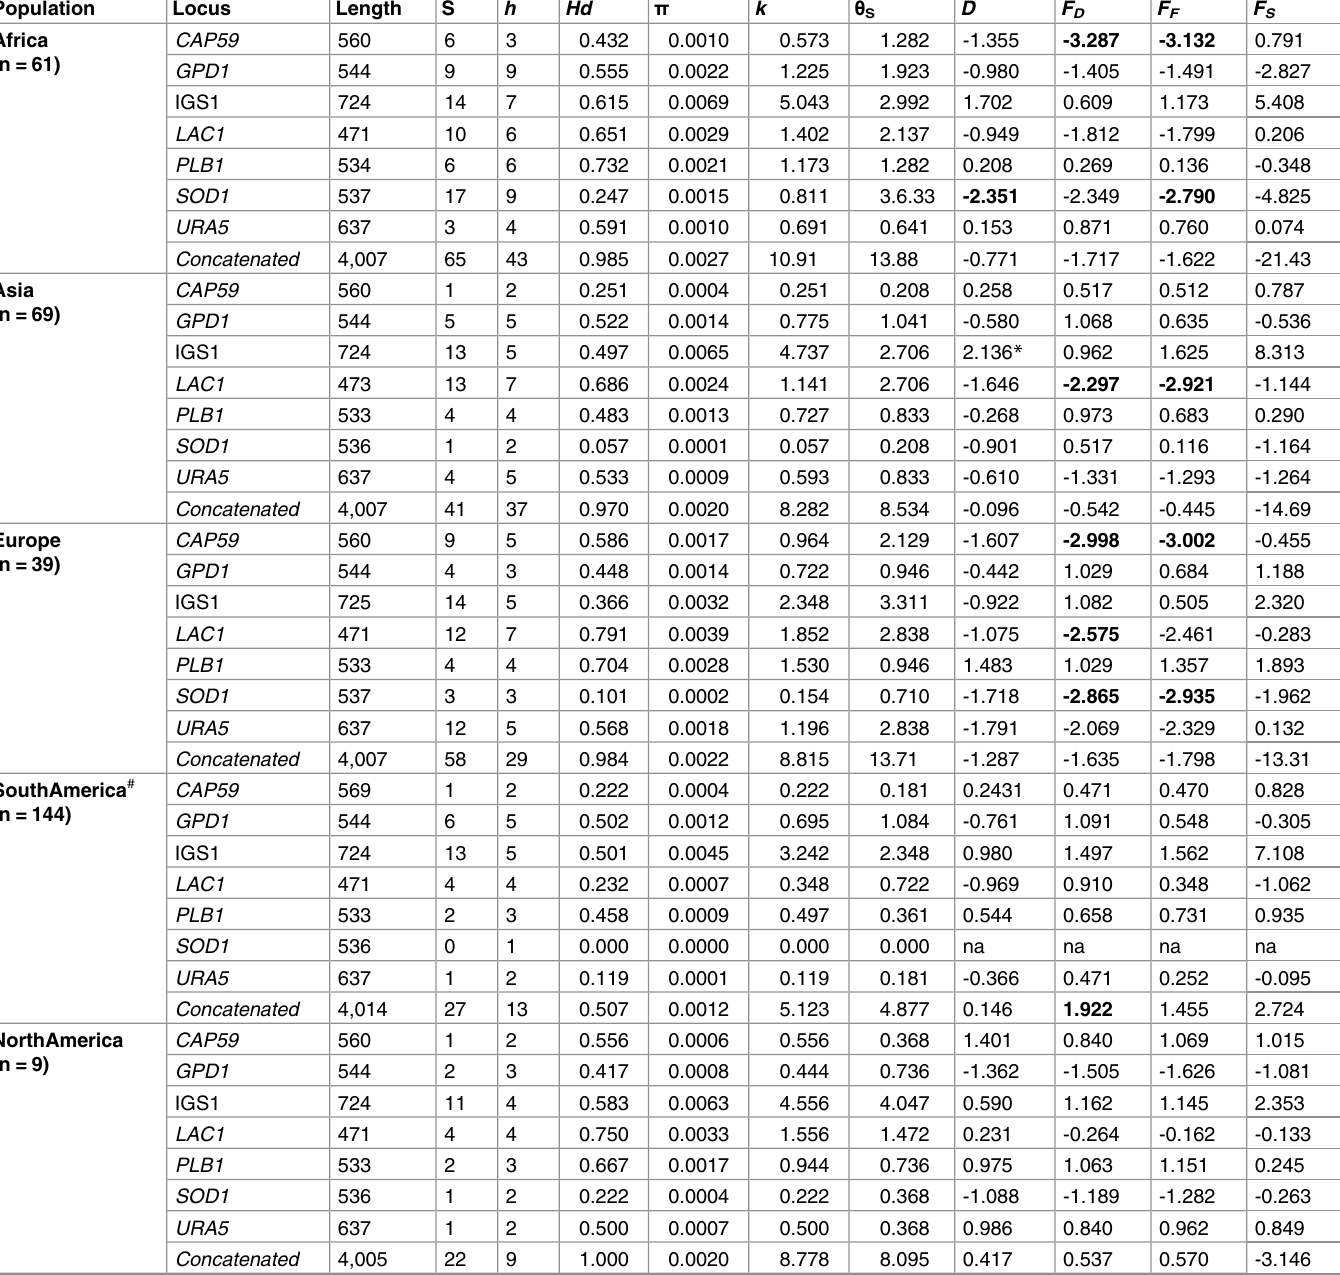
Table 2. Polymorphism data analysesof the single loci and the concatenated dataset of the different Cryptococcus neoformans var. grubii VNI continental populations. Population Locus Africa (n = 61)